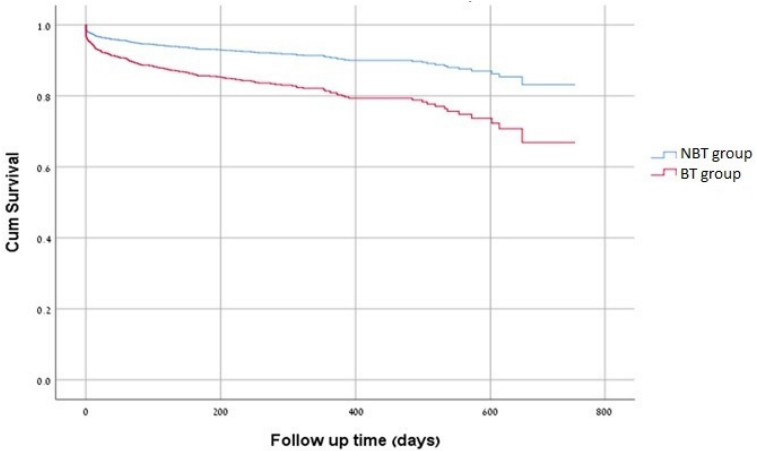
Figure 2. Multivariate Cox Proportional Hazards Analysis. HR = 2.19, 95% CI [1.47–3.62]; p < 0.0001. Table 5. Multivariable regression model for blood transfusion during